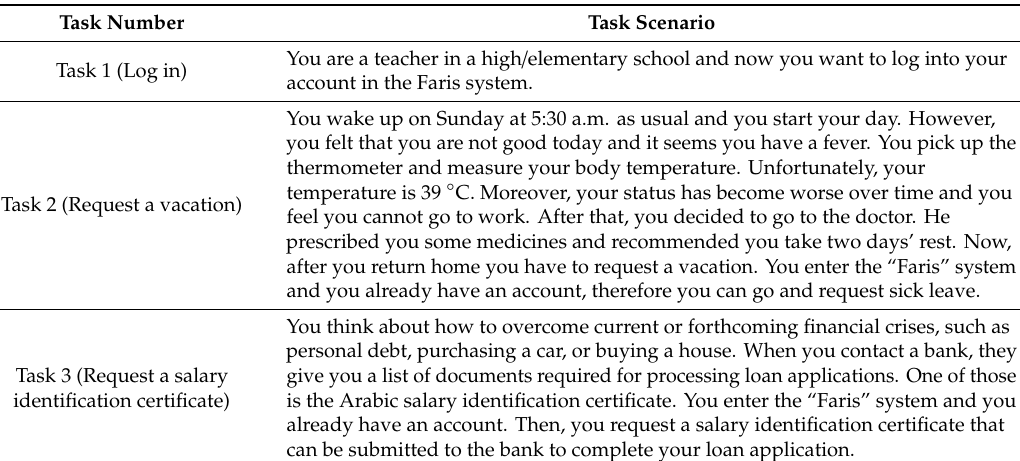
Table 5. Faris system task scenarios.